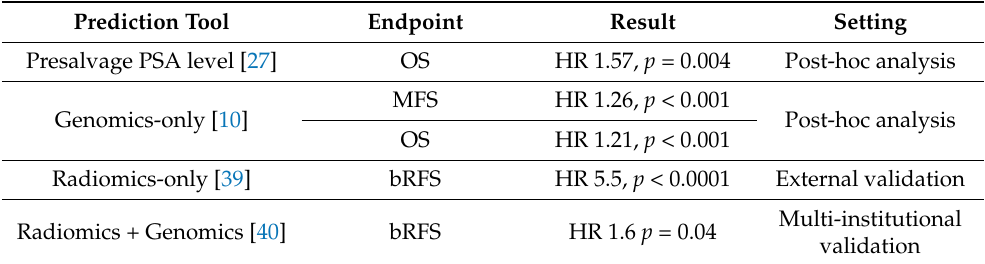
Table 3. Performances of the novel biomarkers for the prediction of patients’ outcomes. Prediction Tool Endpoint Result Setting Presalvage PSA level [27] OS HR 1.57, p = 0.004 Post-hoc analysis MFS HR 1.26, p < 0.001 Genomics-only [10] Post-hoc analysis OS HR 1.21, p < 0.001 Radiomics-only [39] bRFS HR 5.5, p < 0.0001 External validation Multi-institutional Radiomics + Genomics [40] bRFS HR 1.6 p = 0.04